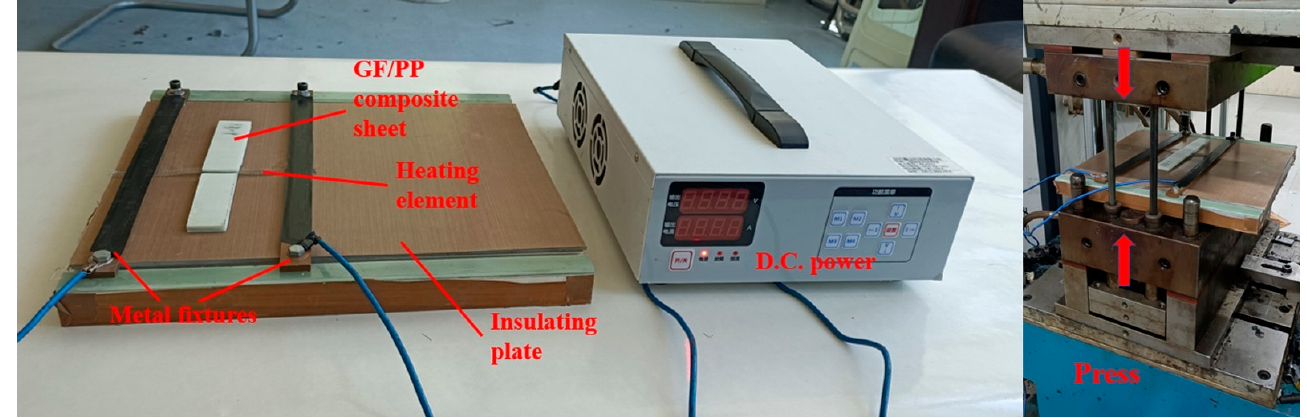
Figure 4. Self-designed resistance welding device.